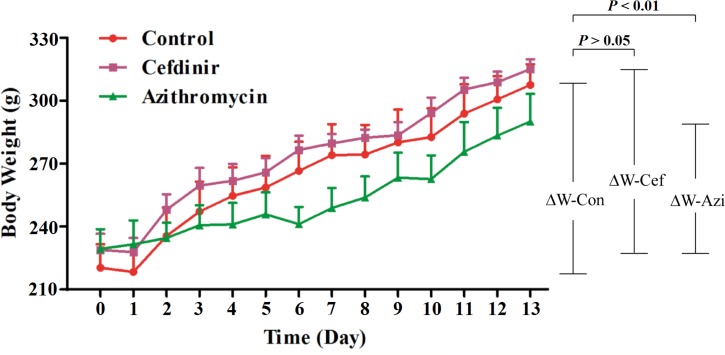
Bodyweight variation in the control, cefdinir- or azithromycin-treated groups.ΔW-Con: weight gain in the control groups. ΔW-Cef: weight gain in the cefdinir-treated groups. ΔW-Azi: weight gain in the azithromycin-treated groups. All measurements were between day 0 and day 13.